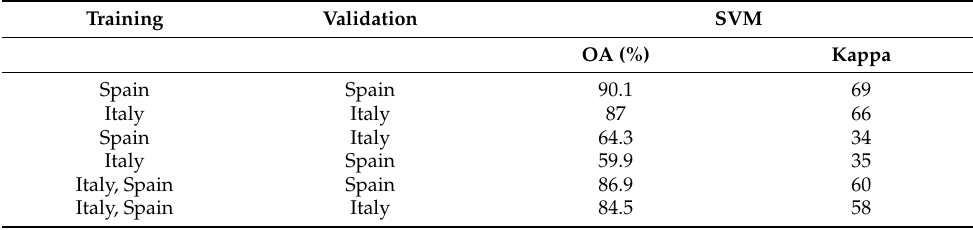
Table 2. Performances for the different training